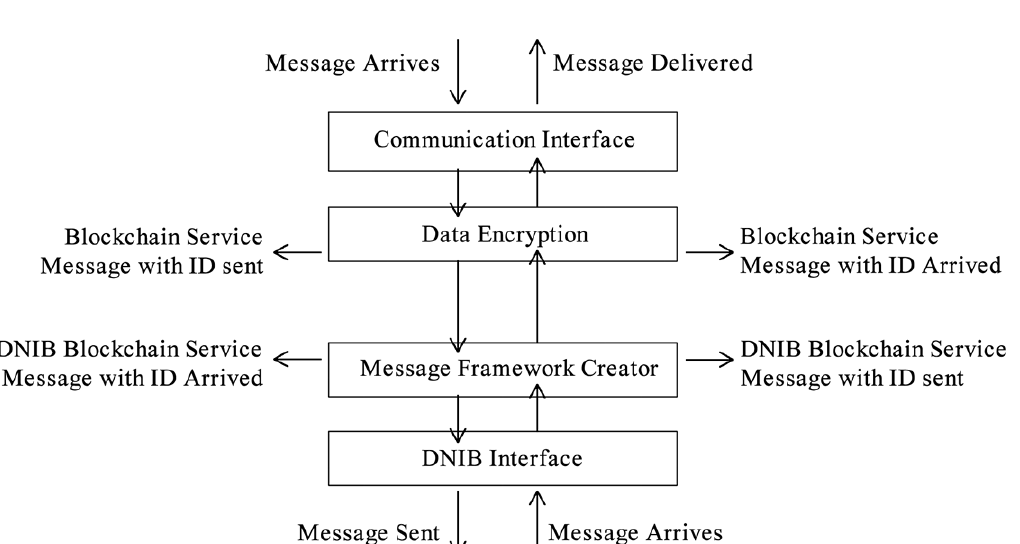
Figure 7. DNIBI components.